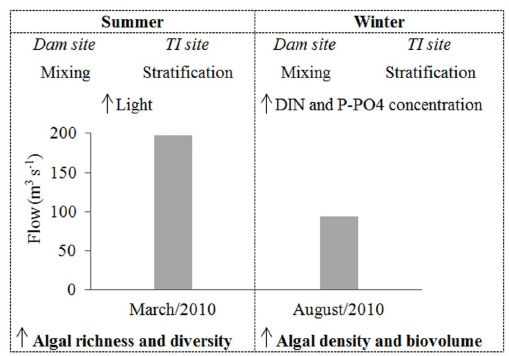
Figure 6. Schematic diagram summarizing the main changes in abiotic and biotic variables between seasons in an urban hypereutrophic